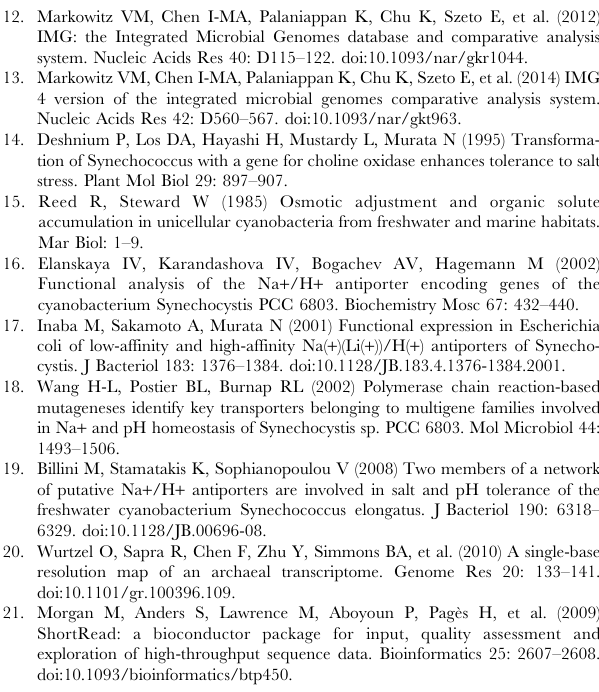
Table S1 Read mapping statistics for the different samples. (XLSX)